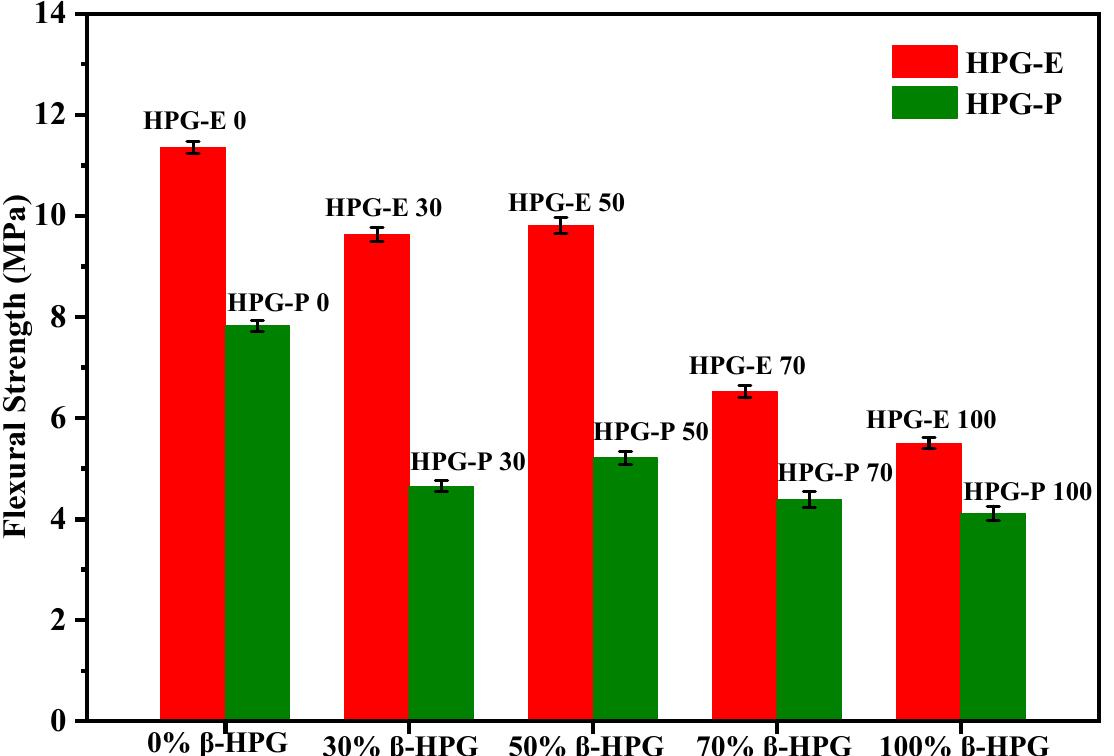
Figure 2. Flexural strength of HPG-P composites and HPG-E composites.